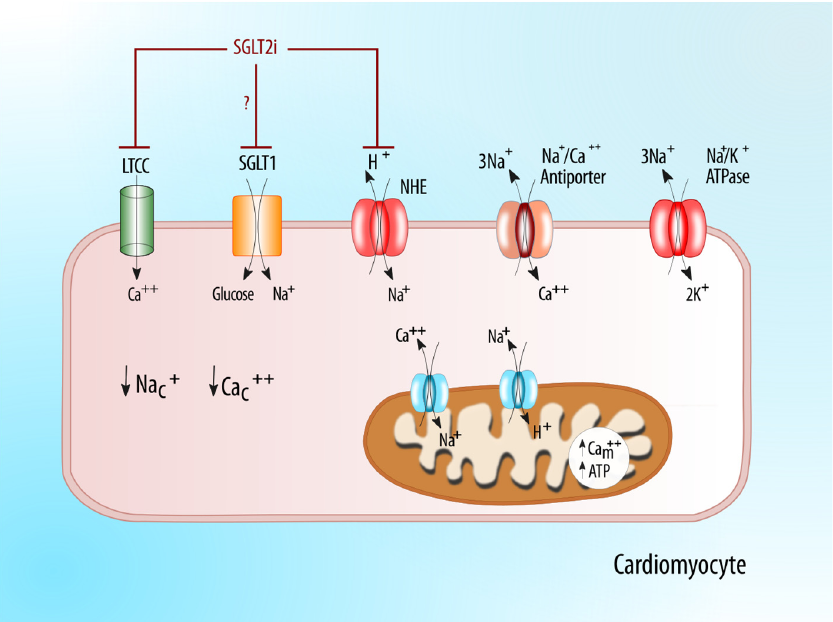
Figure 3. Direct effects of SGLT2ion the cardiomyocyte: inhibition of NHE1 on cardiomyocite could reduce Na and Ca intracellular concentration overload, the pathogenetic pathway of contractile failure [11,15]. Abbreviations : LTCC, L-Type Calcium Channels; NHE, sodium / hydrogen exchanger; Na c + , intracitoplasmatic sodium; Ca c++ , intracitoplasmatic calcium; Ca m ++ , intramitochondrial calcium. At this time, the physiologic impact and direct cardiac tissue e ff ect of SGLT2i have not been fully assessed, but preclinical data suggest that they have protective e ff ects on cell survival, function, and organ